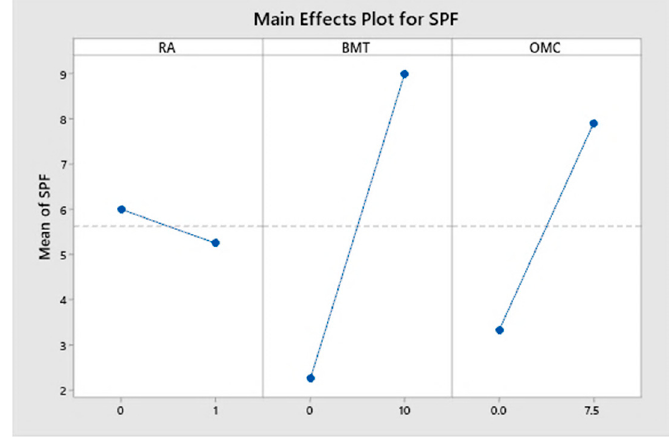
Figure 5. Graph of main effects for in vitro SPF of the formulations.